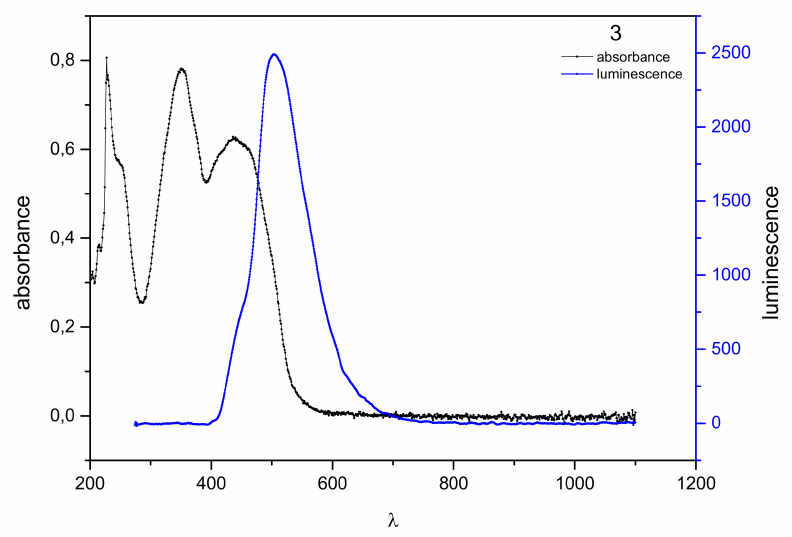
Figure 3. Normalized absorption spectra (black) and emission spectra (blue) of 3 in dichloromethane solution (10 − 6 mol / dm 3 ).